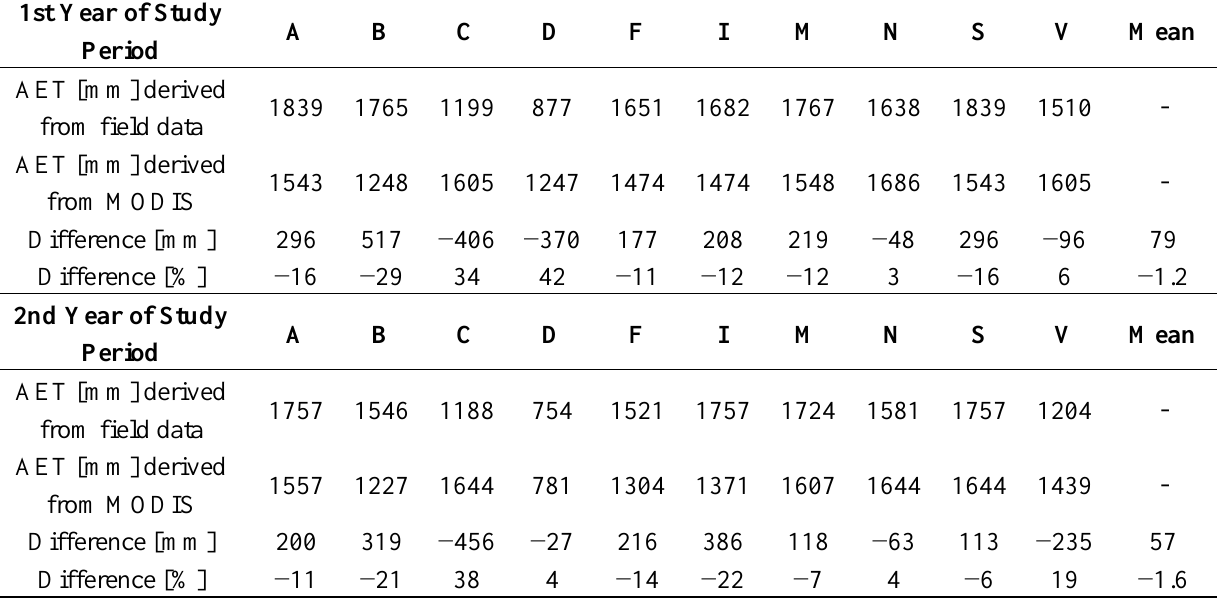
Table 4. Yearly actual evaporation (AET) [mm] derived from MODIS satellite- and ground-based inundation assessment as well as differences of AET rates [mm and %] for all